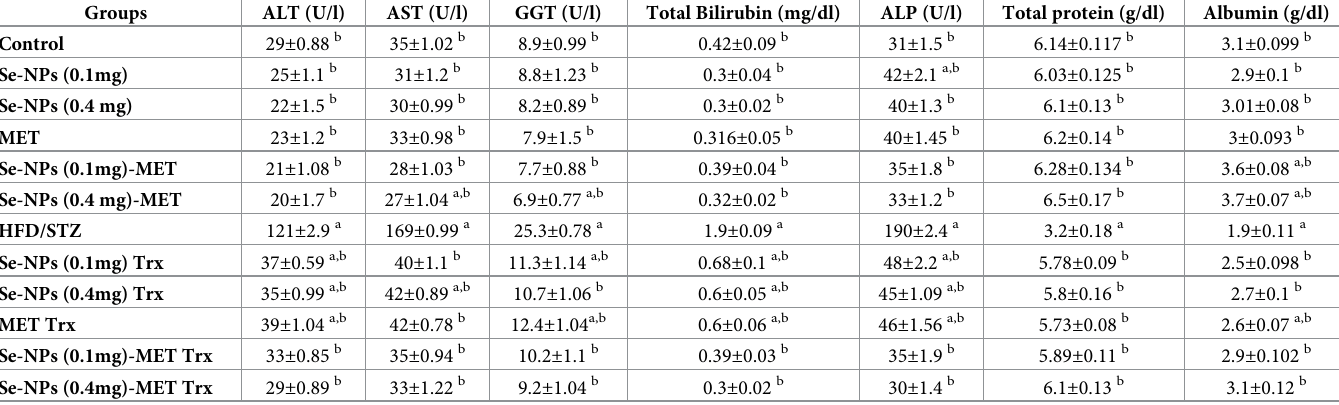
Values are mean ± SE (n = 10). Significant changes (p < 0.01) with respect to control and HFD/STZ-experimental rats are expressed by the letters (a) and (b),